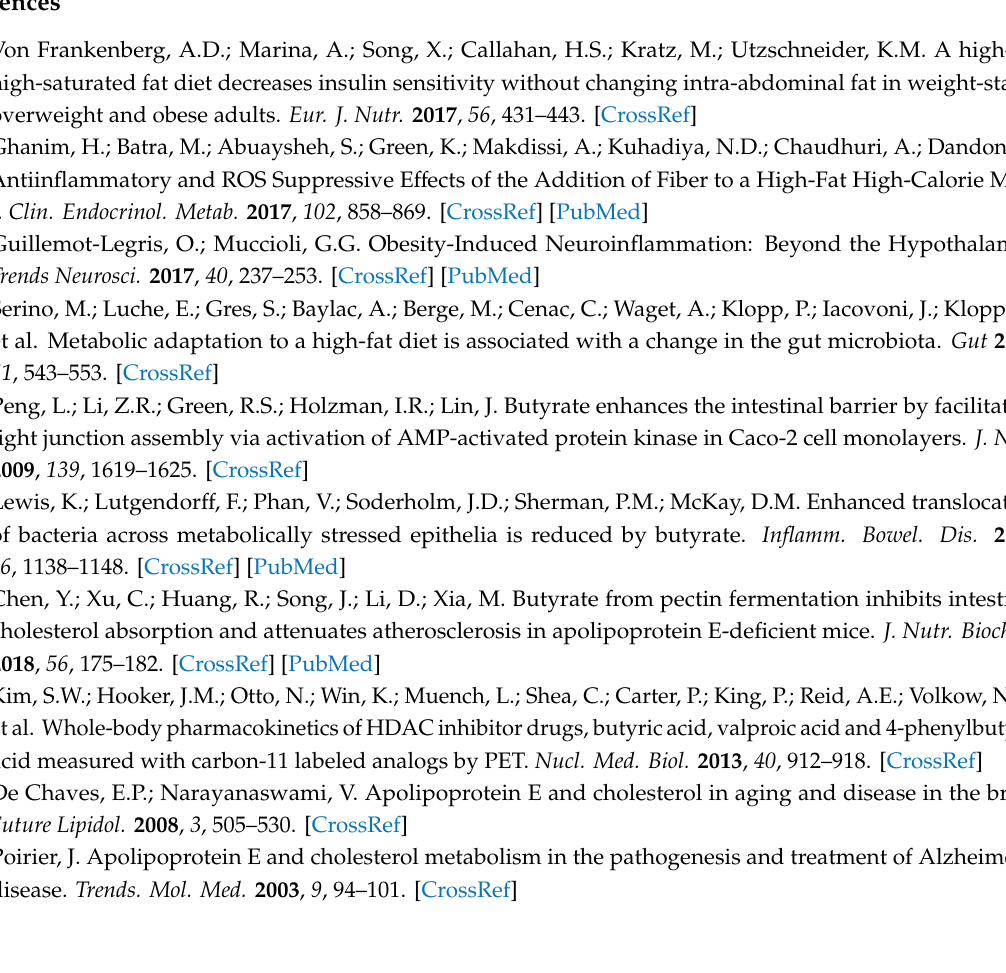
Figure S1: Changes in serum triglycerides measured in the tail vein in individual Apolipoprotein E-knockout (ApoE- / -) rats fed a low-fat diet (LF) or high-fat diets (HF), pure or supplemented with 1% monobutyrin (MB) or monovalerin (MV) for 5 weeks ( n = 10 / group). Figure S2: Other parameters measured in conventional rats fed a pure high-fat diet (C), or Apolipoprotein E-knockout (ApoE- / -) rats fed a low-fat diet (LF) or high-fat diets (HF), pure or supplemented with 1% of monobutyrin (MB) or monovalerin (MV) ( n = 10 / group) for 5 weeks. (a) Portal vein serum glucose (mmol / L), (b) portal vein white blood cell counts. Figure S3: Tissue weights in conventional rats fed a pure high-fat diet (C), or Apolipoprotein E-knockout (ApoE- / -) rats fed a low-fat diet (LF) or high-fat diets (HF), pure or supplemented with 1% monobutyrin (MB) or monovalerin (MV) for 5 weeks ( n = 10 / group). Table S1: Composition of experimental diets (g / kg, dry weight basis) given to conventional rats fed a pure high-fat diet (C) or to Apolipoprotein E-knockout (ApoE- / -) rats fed a low-fat diet (LF) or high-fat diets (HF), pure or supplemented with 1% monobutyrin (MB) or monovalerin (MV) for 5